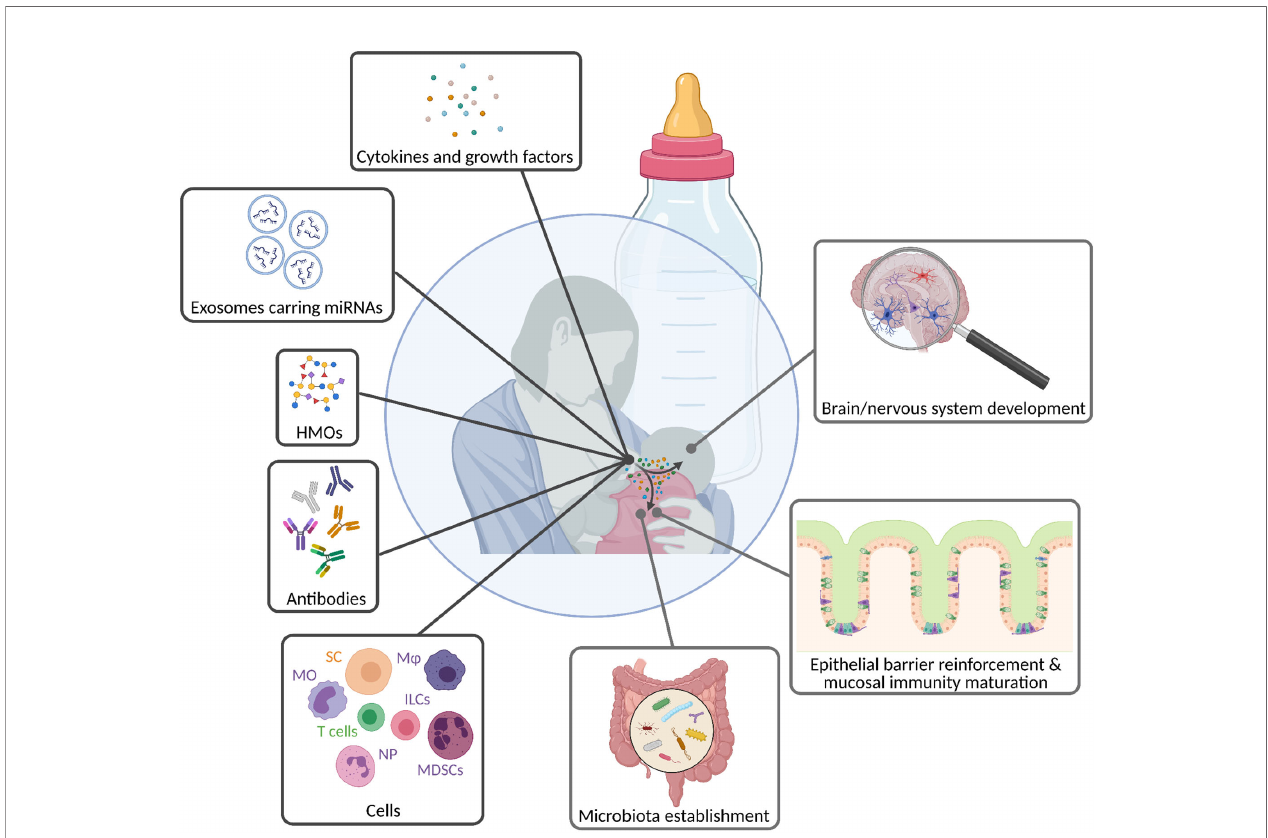
FIGURE 4 | Breastfeeding mediates the transfer of biologically active molecules from the mother to the infant. Breast milk contains a huge diversity of components, ranging from simple sugars, antibodies, and cells to molecules that directly trigger reactions in target cells and/or tissues, such as cytokines, growth factors, and exosomes. Thereby, milk molecules ensure the infant ’ s well-being by driving innate and adaptive immune maturation, and further contributing to the development of its mucosal and nervous system. HMOs, human milk oligosaccharides; ILCs, innate lymphoid cells; M j , macrophages; MDSCs, mononuclear-derived suppressor cells; MO, monocytes; NP, neutrophils; SC, stem